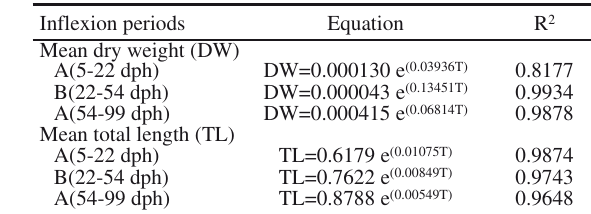
Table 3. – Equation and coefficient of determination (R 2 ) of each regression period for mean dry weight and mean total length values (see Figs 3 and 4). DW, dry weight; T, age (dph); TL, total